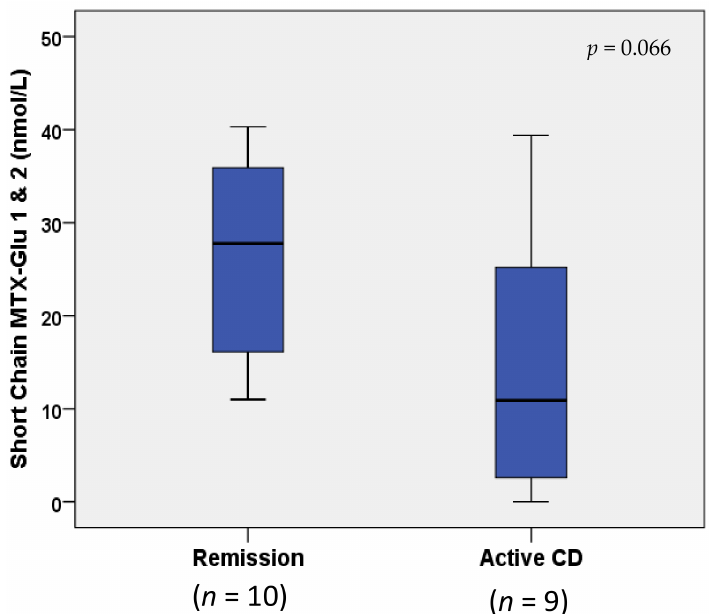
Figure 2. Box and whisker plot comparison of erythrocyte MTX-Glu 1–2 concentrations in remission vs. active Crohn’s disease. Horizontal line in boxes represents median value, with whiskers representing the